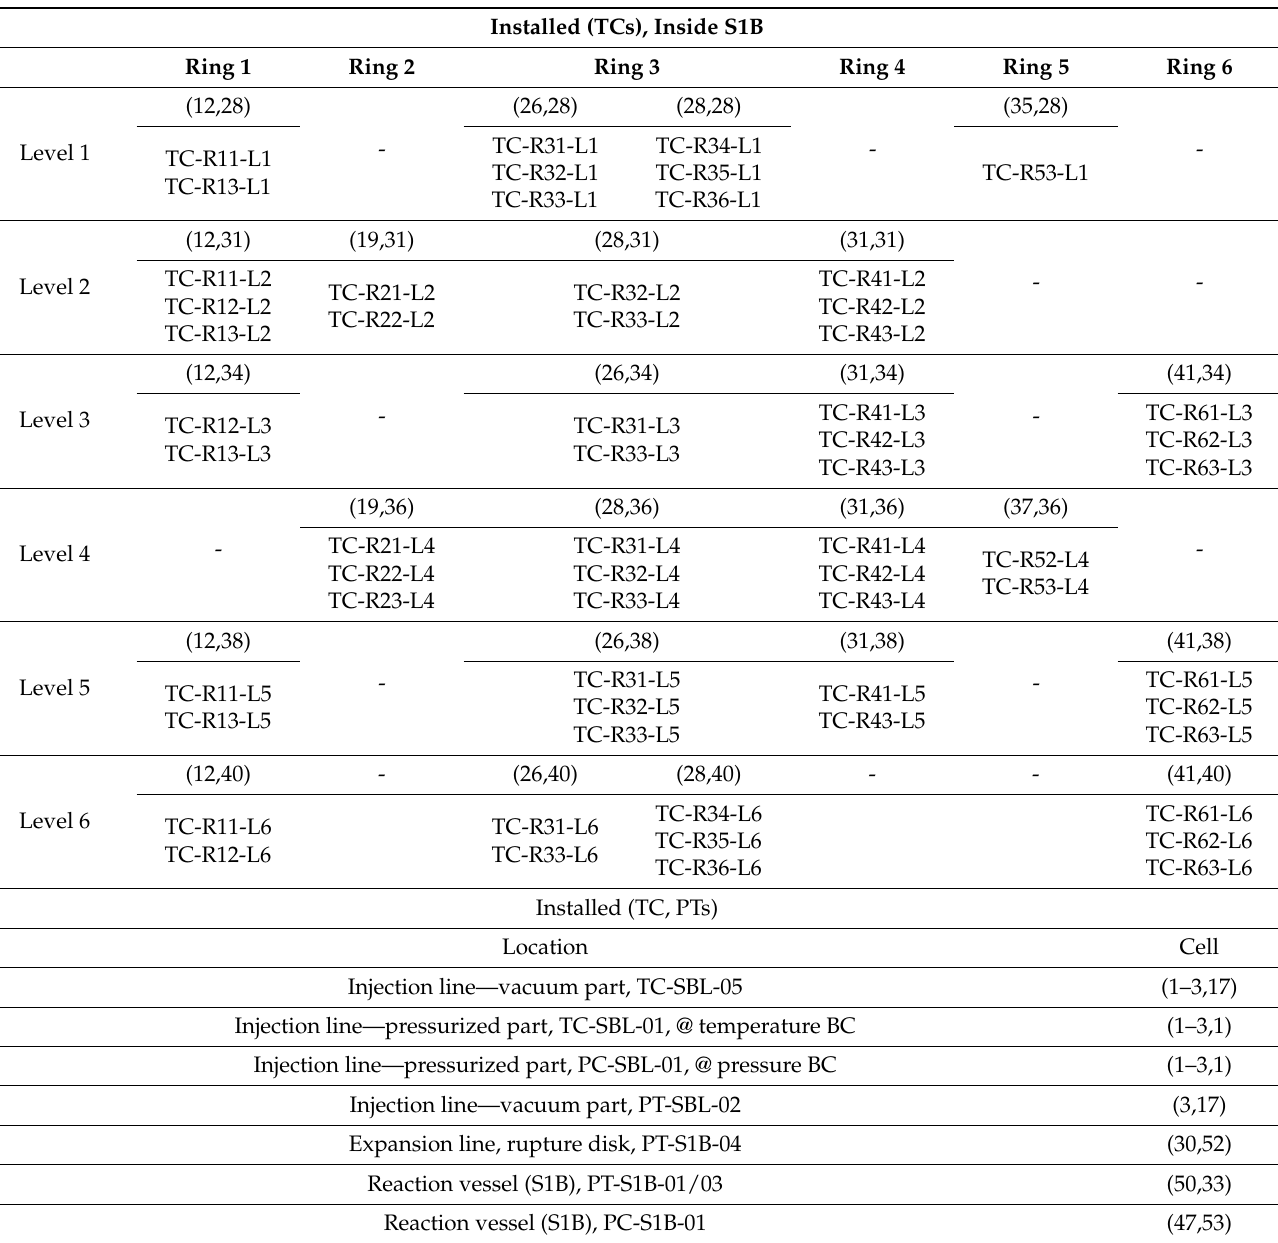
Table 5. Location of the TCs and PTs on the SIMMER-III reference